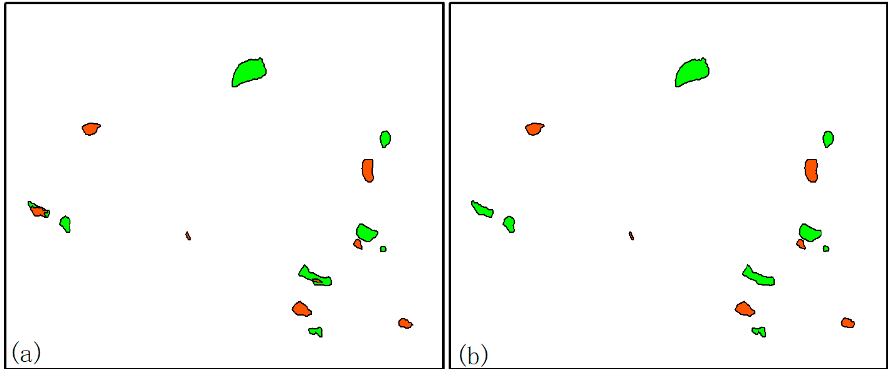
Figure 13. The example of fusing extractions of AT and DT: ( a ) superposition of AT (red) and DT (green) recognition results, ( b ) the fusion result.